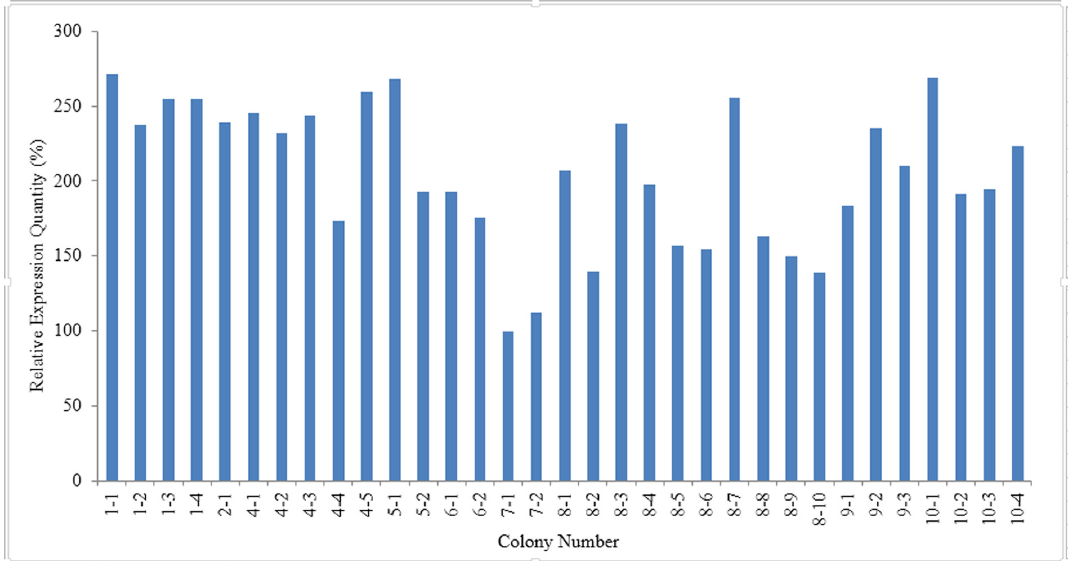
FIGURE 5 - Relative expression yield of mt-PA after clonal selection of different clones. The colonies exhibiting highest productivity were subjected to the Amidolytic activity